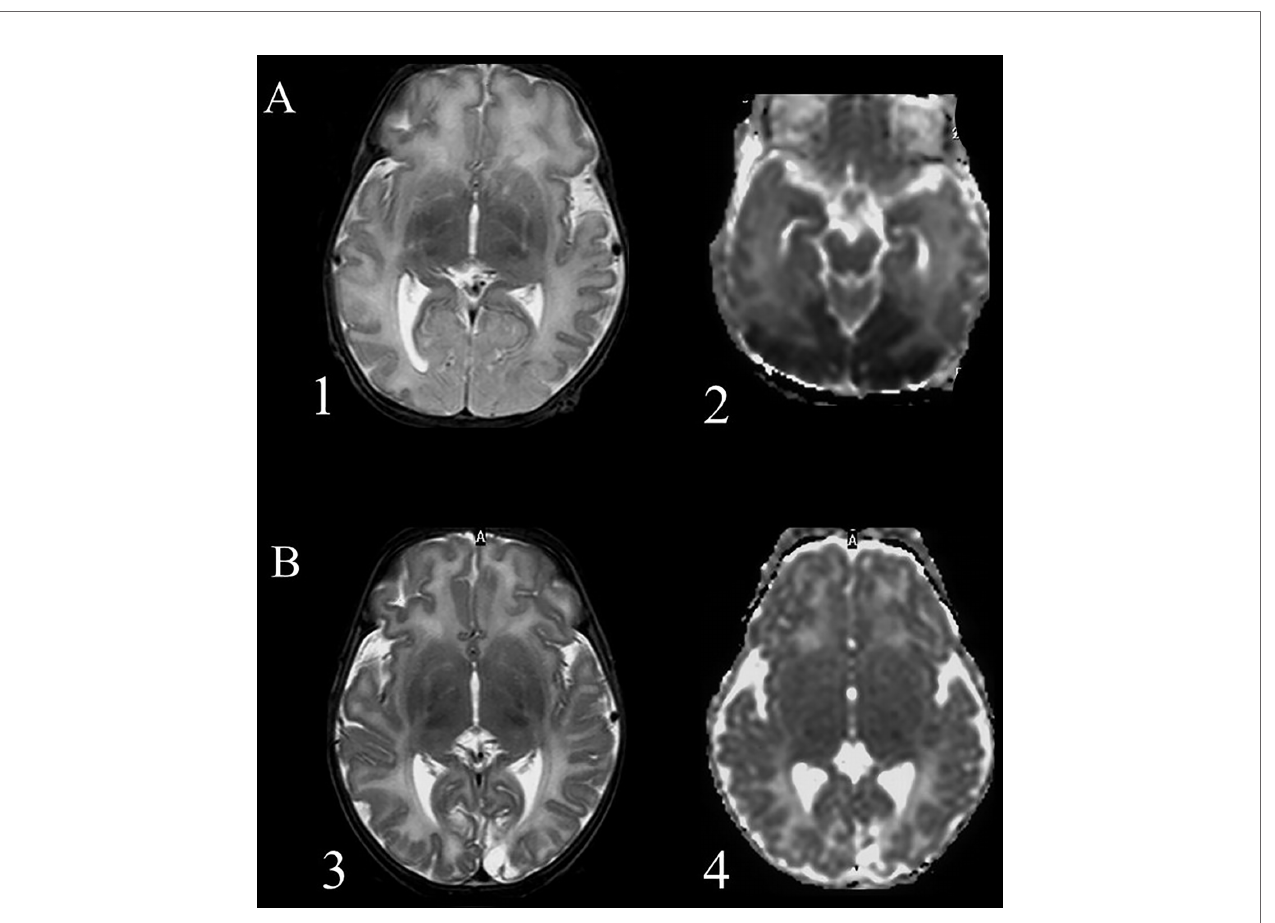
FIGURE 1 | Magnetic resonance imaging of a term newborn with apnea and seizures associated with severe hypoglycemia. (A) scans performed after 5 days from the event (acute phase), 1 = axial T2 weighted imaging showing an extensive cortical and subcortical damage, manly in the occipital lobes, with loss of cortical differentiation; 2 = Diffusion weighted imaging shows a large posterior subcortical area of reduction of the apparent diffusion coef fi cient. (B) scans performed after 5 weeks (chronic phase): 3 = Presence of an occipital atrophic area, more extended within the left occipital lobe; 4 = Diffusion weighted imaging shows an increased water diffusion in the affected areas and a smaller